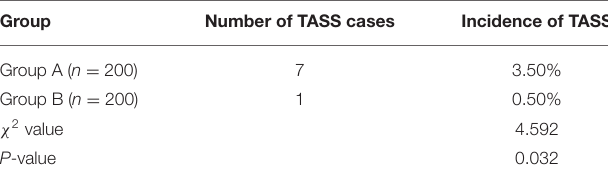
TABLE 5 | Comparison of the incidence of TASS between two groups ( n , %).